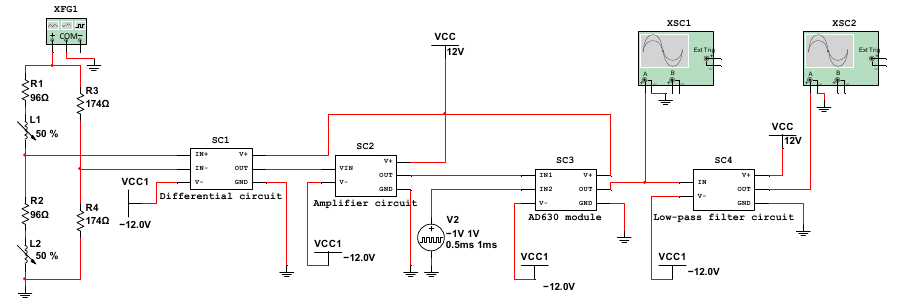
Figure 8. Simulation model of the conditioning circuit.